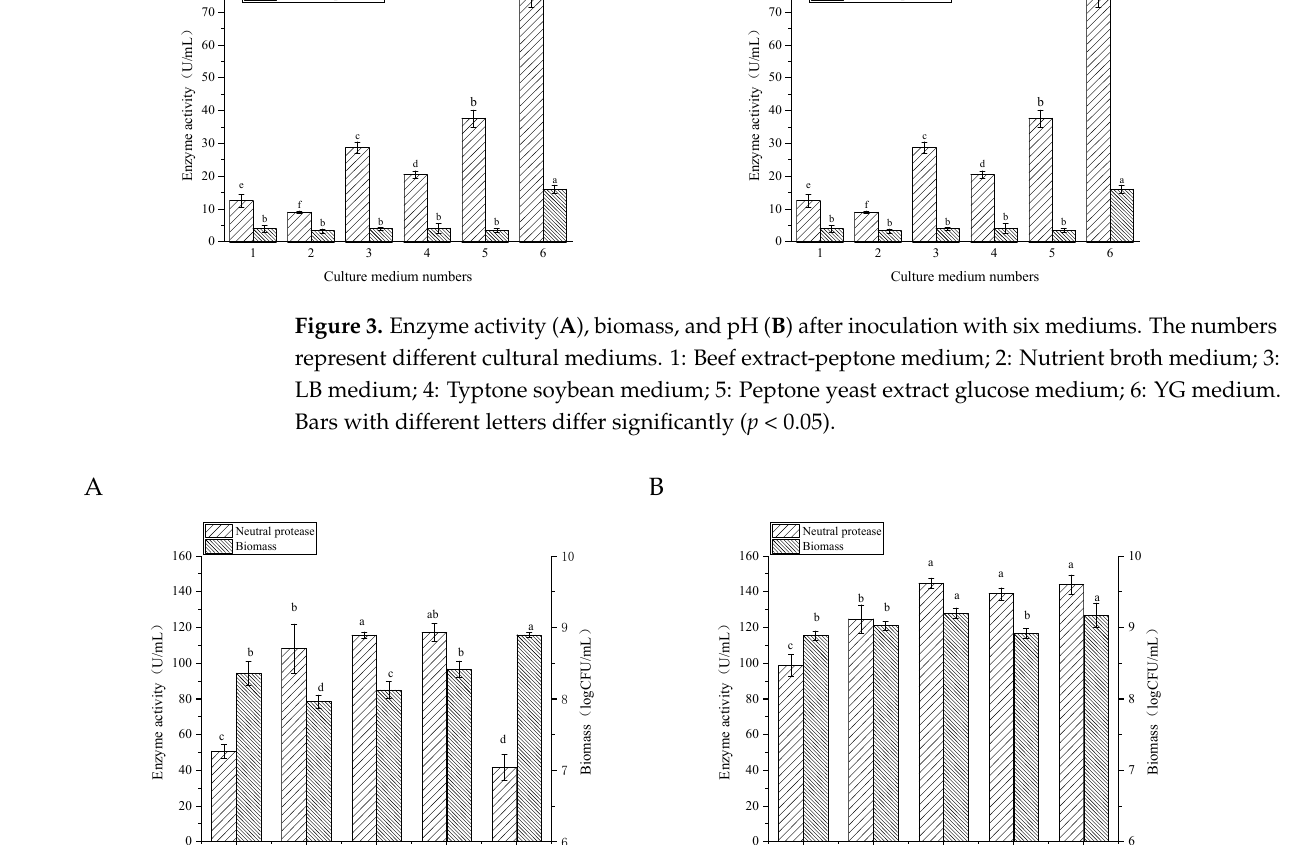
Figure 3 . Enzyme activity ( A ), biomass, and pH ( B ) after inoculation with six mediums. The num- bers represent different cultural mediums. 1: Beef extract-peptone medium; 2: Nutrient broth me- dium; 3: LB medium; 4: Typtone soybean medium; 5: Peptone yeast extract glucose medium; 6: YG medium. Bars with different letters differ significantly ( p < 0.05).